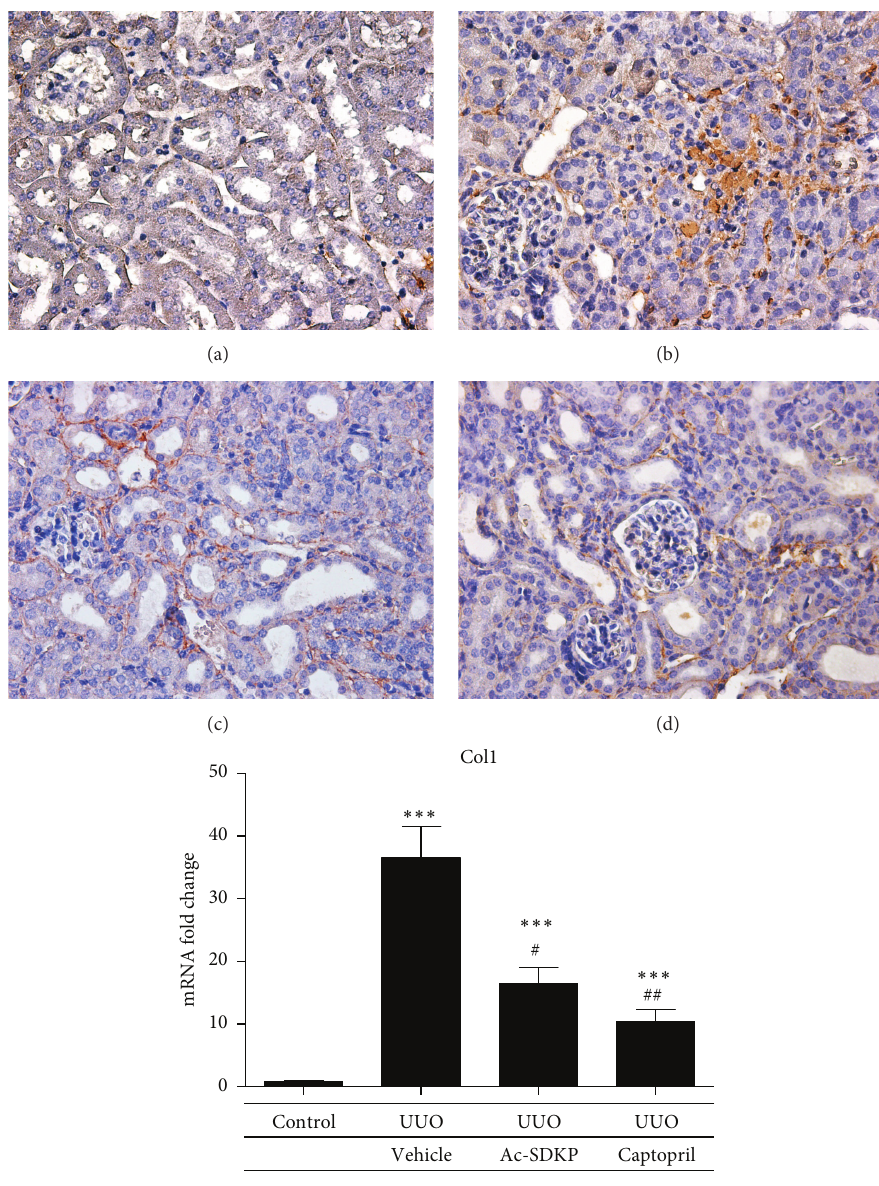
Figure 6: Collagen I expression in renal cortical tissue. (a–d) Representative immunohistochemical staining of protein expression from control animals (a), UUO operated animals (b), UUO animals with Ac-SDKP treatment (c), and UUO animals with Captopril treatment (d). Magnification (400x). (e) Quantitative analysis of mRNA expression by